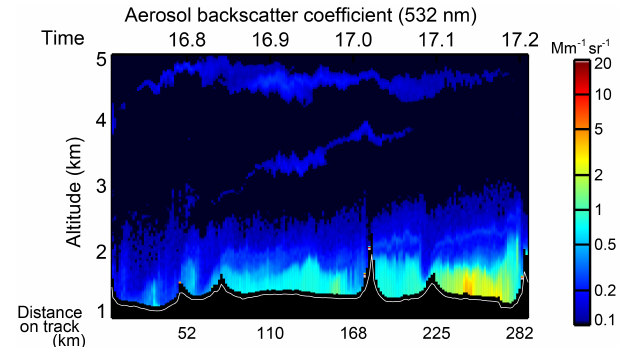
Figure 6. Measurement curtain of aerosol backscatter coefficient at 532nm from the HSRL-2 instrument for a 280km flight segment over the southwestern US on 8 February 2013, showing locally gen- erated dust in approximately the first kilometer above the surface, as well as very tenuous smoke plumes at higher altitude. This flight segment was part of a transit flight from a field mission in Cali- fornia back to the B200 home base in Virginia. The selected flight segment is approximately 280km and begins (at the left margin) on the slopes of the Dos Cabezas Mountains of Arizona and ends (at the right margin) at the Franklin Mountains in New Mexico. The ground surface is marked with a white